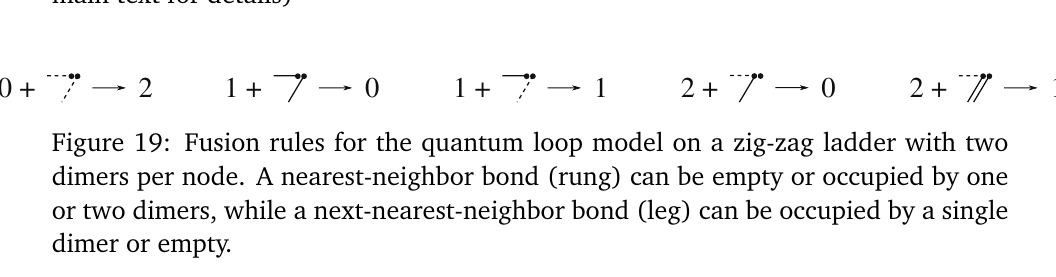
Figure 19: Fusion rules for the quantum loop model on a zig-zag ladder with two dimers per node. A nearest-neighbor bond (rung) can be empty or occupied by one or two dimers, while a next-nearest-neighbor bond (leg) can be occupied by a single dimer or